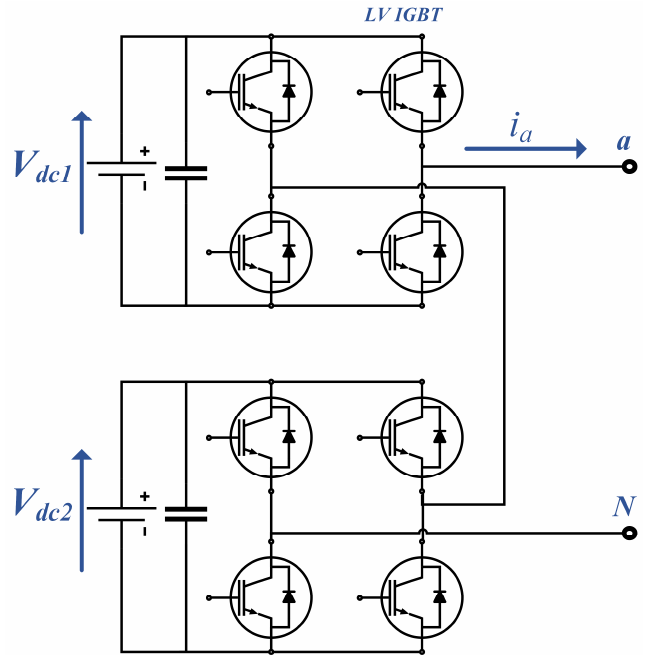
Figure 13. Two cells, a five-level cascaded H-bridge converter phase leg.